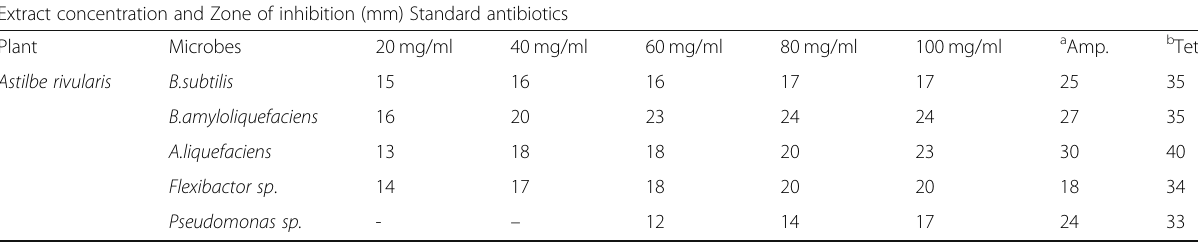
Flexibactor sp . 14 Pseudomonas sp. -